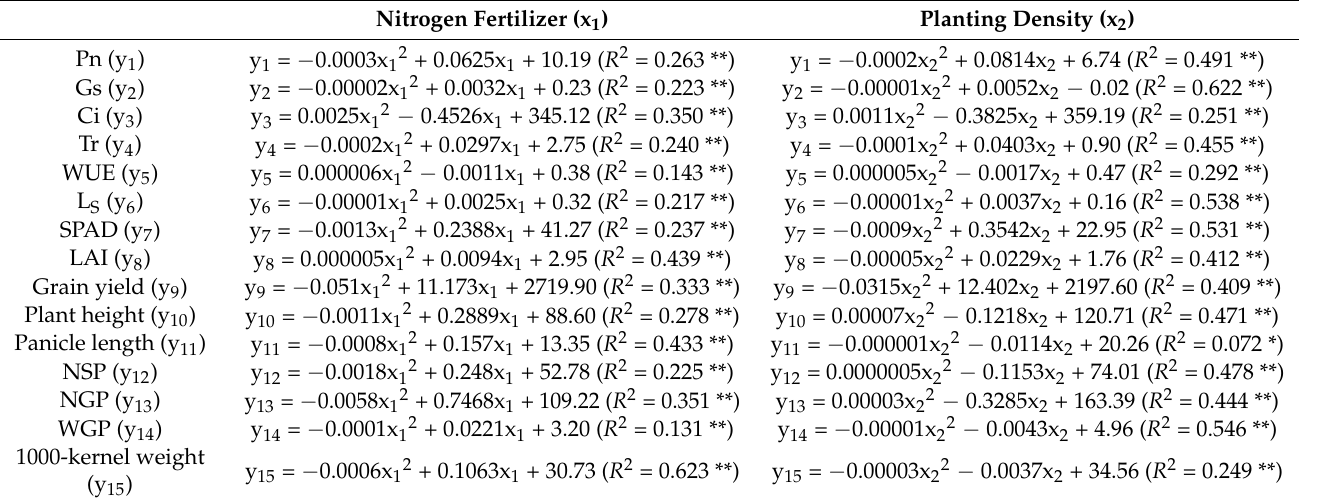
Table 4. Regression of net photosynthetic rate (Pn), stomatal conductance (Gs), intercellular CO 2 concentration (Ci), transpiration rate (Tr), water-use efficiency (WUE), stomatal limitation value (Ls), leaf area index (LAI), grain yield, plant height, panicle length, number of spikelets per panicle (NSP), number of grains per panicle (NGP), weight of grains per panicle (WGP), and 1000-kernel weight of oat on nitrogen fertilizer or planting density; * and ** significant at p < 0.05 and p < 0.01, respectively.